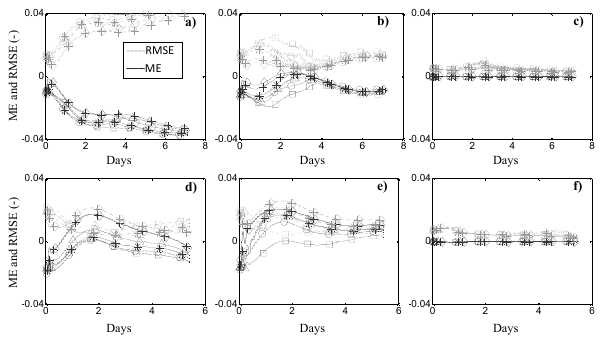
Figure 10. Evolving mean errors (MEs) and root mean square er- rors (RMSEs) between predicted and measured profiles using GA3 (a–c) and GB1 (d–f) experimental data series, with assimilation fre- quency AF = 1/2h − 1 , and observation depths: (a, d) OD = 1cm, (b, e) OD = 2cm, and (c, f) OD = 12cm. The analysis accounts for the six pondered sets of initial parameters S1( (cid:13) ) , S2( (cid:3) ) , S3( ∗ ) , S4( 1) , S5( + ) and S6( ♦ )